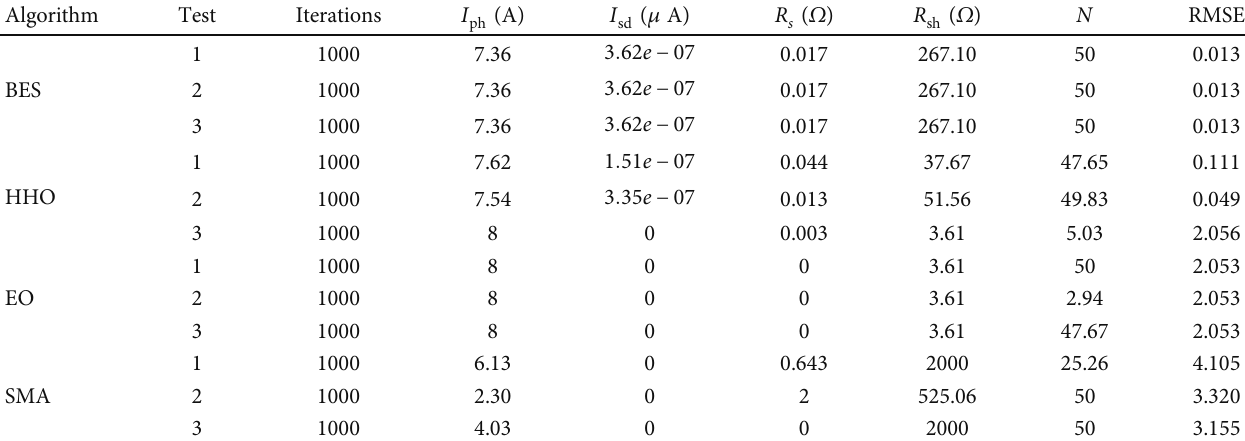
Table 2: Validation of parameter vectors from 3 trials with 1000